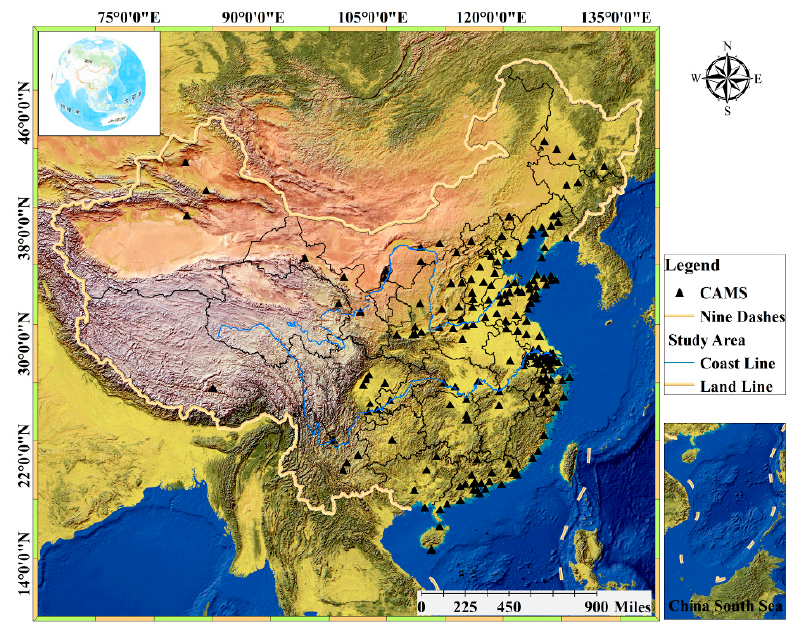
Figure 1. The study area.